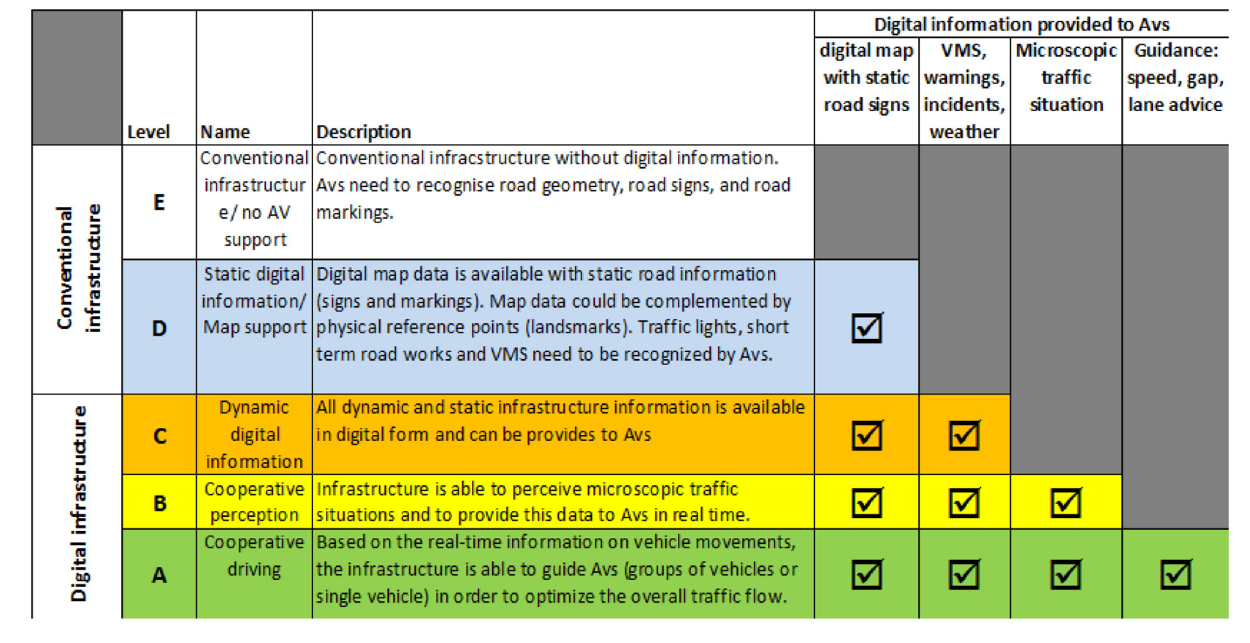
FIGURE 15 | ISAD, the levels of readiness of road infrastructure for AVs